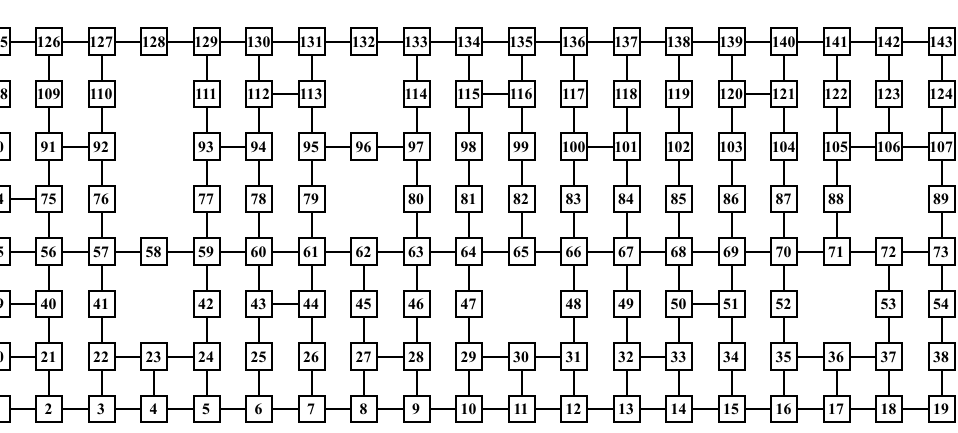
Figure 2. Layout model of a bidirectional transport system with 143 nodes. The squares numbered 1 to 143 represent the nodes that make up the transport system. Each AGV can move to adjacent nodes connected by